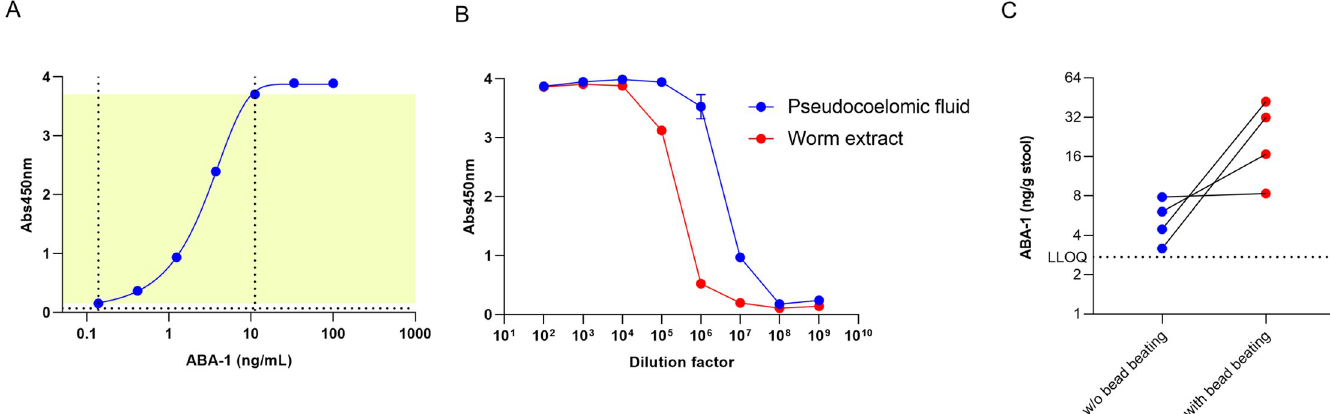
Fig 1. A. Calibration curve for the ABA-1 coproantigen ELISA. Yellow area indicates the dynamic range of the assay, left vertical dotted line corresponds to the LLOQ (0.137 ng/mL), right vertical dotted line to the ULOQ (11.1 ng/mL), the horizontal dotted line corresponds to the background signal detected in blanks. B. Analysis of a serial dilution of pseudocoelomic fluid (blue circles) and an adult worms extract (red circles) on the ABA-1 ELISA. C. ABA-1 coproantigen ELISA using stool extracts with and without bead beating indicates that a cell destruction step is needed to release ABA-1 in the stool supernatant.